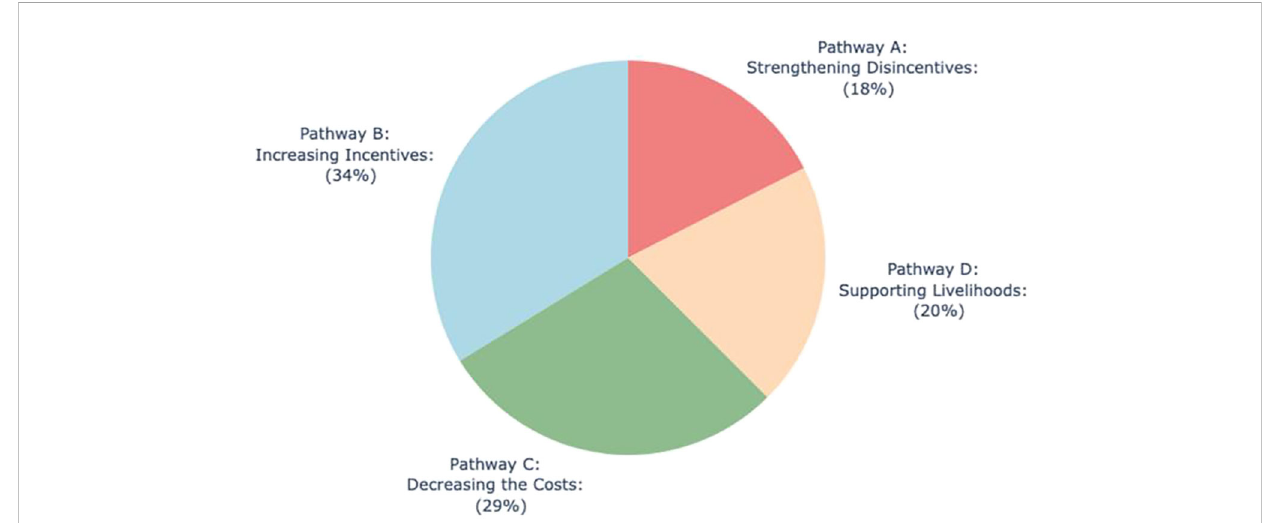
FIGURE 3 Distribution (%) of pathways used to address illegal wildlife trade in felids in our included case studies. The pathways are: (A) strengthening disincentives for illegal behavior (e.g., through community scouts and incentivizing patrols); (B) increasing incentives for wildlife stewardship (e.g., through tourism, resource access); (C) decreasing the costs of living with wildlife (e.g., physical barriers to protect livestock); and (D) supporting livelihoods that are not related to wildlife (e.g., enterprise support) (Biggs et al.,